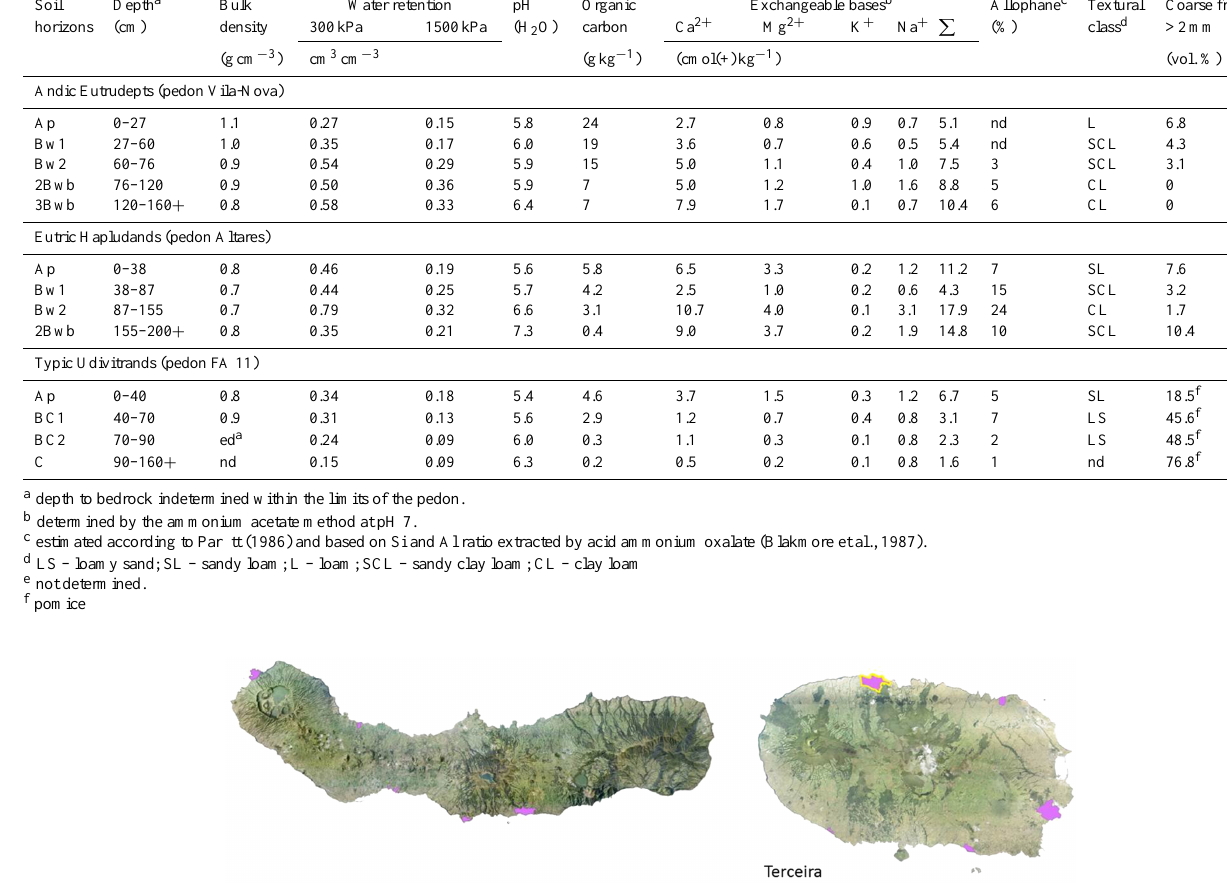
Table 1. Pedological properties of three soils representative of the potential new areas for viticulture in the Azores. Soil Depth a Bulk Water retention pH Organic Exchangeable bases b Allophane c Textural Coarse fraction horizons (cm) density